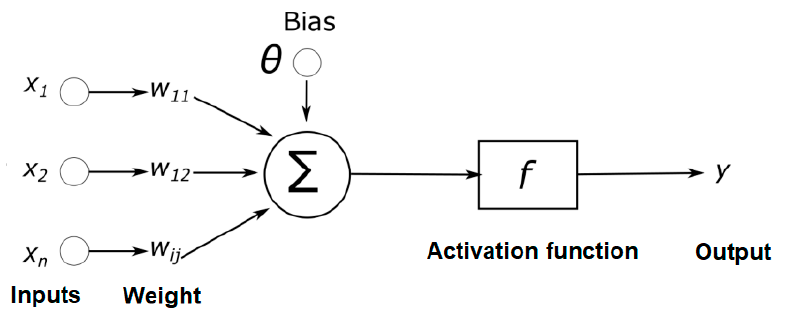
Figure 5. Simple neuron structure.